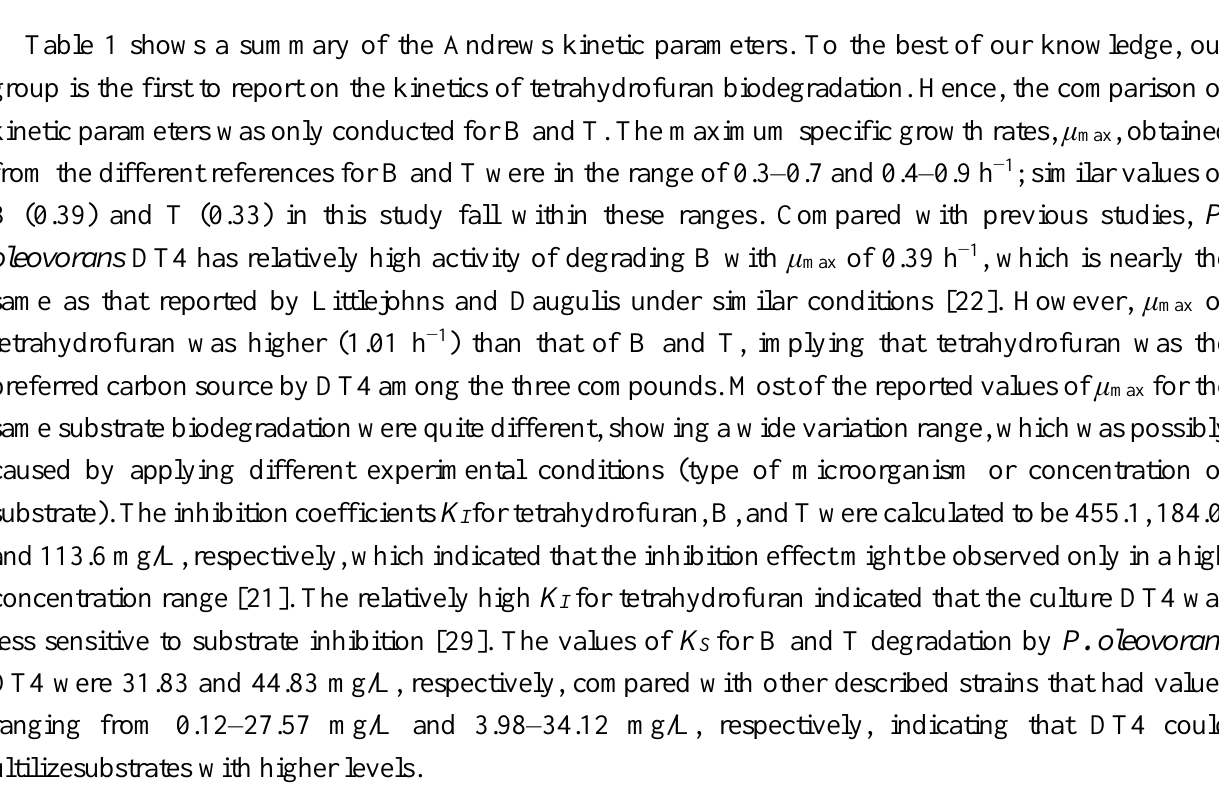
Table 1. Biodegradation model parameter values for tetrahydrofuran, B, and T by various microorganisms as described in the